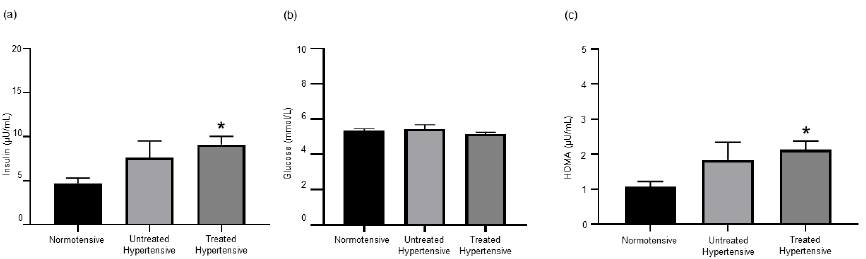
Figure4. ( a )Insulinlevelsareelevatedinhypertensivepatients. *normotensivevs. treatedhypertensive p = 0.027; ( b ) serum glucose concentrations; and ( c ) insulin resistance index. * normotensive vs. treated hypertensive p = 0.05. n = 11–18 subjects / group. All data are presented as the mean ± SEM. HOMA, homeostatic model